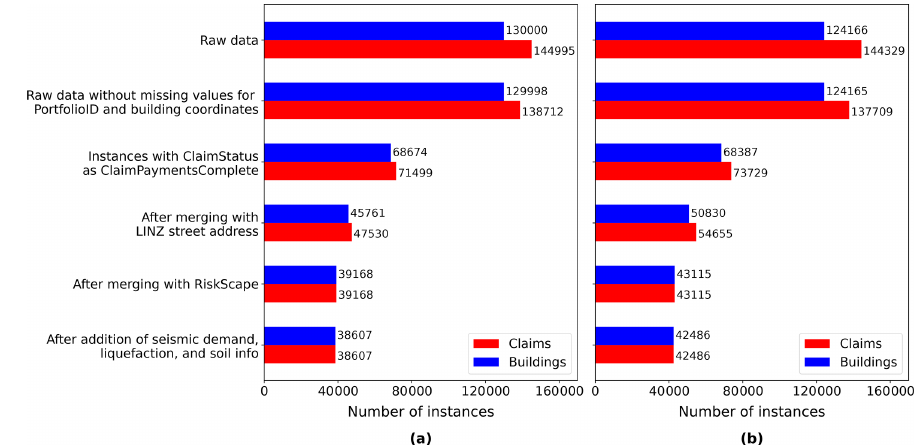
Figure 5. The number of data points after each processing step for the event on (a) 4 September 2010 and (b) 22 February 2011.